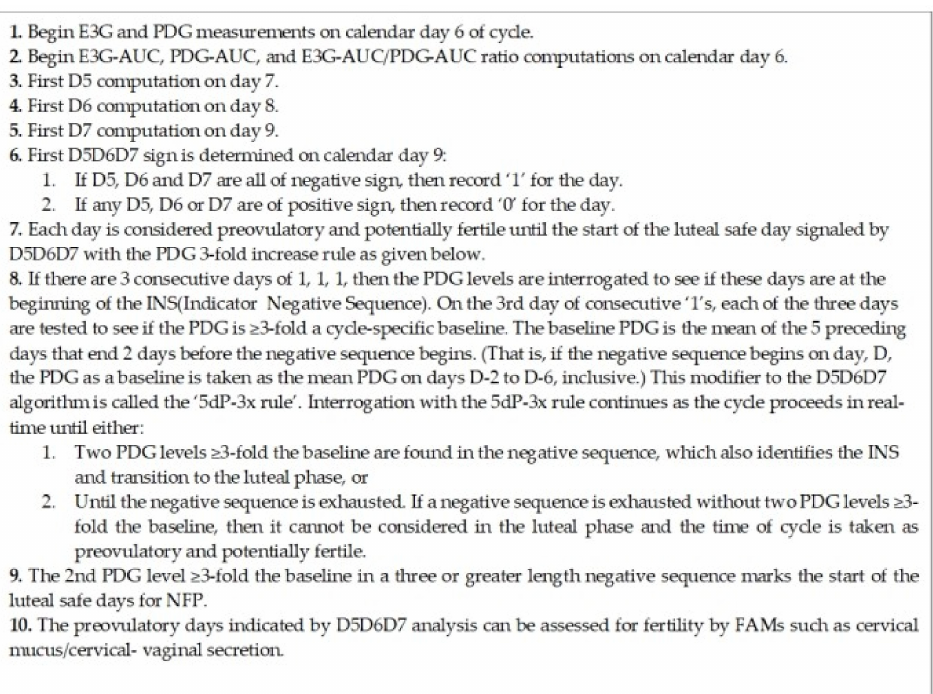
Figure 3. Summary of the algorithm for the D5D6D7 convolution analysis with the PDG modifier. Steps are given for computer programming of a home E3G, PDG monitor which signals the tran- sition to the luteal phase and the start of the luteal safe days for NFP. The D5, D6, and D7 (Delta computations) are described in the Sections 2 and